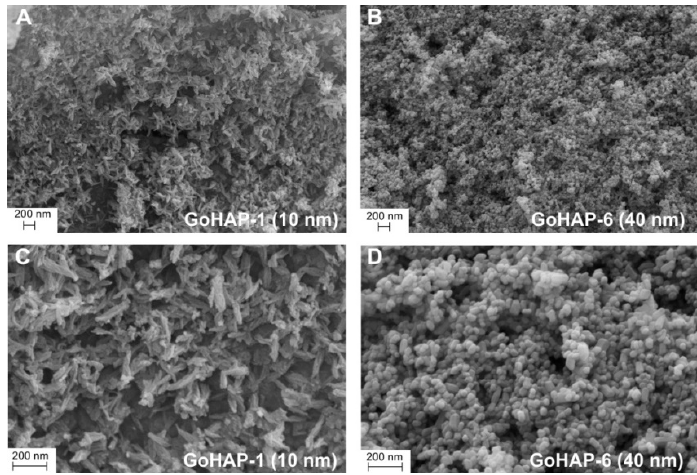
Figure 2. SEM image of GoHAP™ with different particle sizes of 10 nm ( A,C ) and 40 nm ( B,D ).